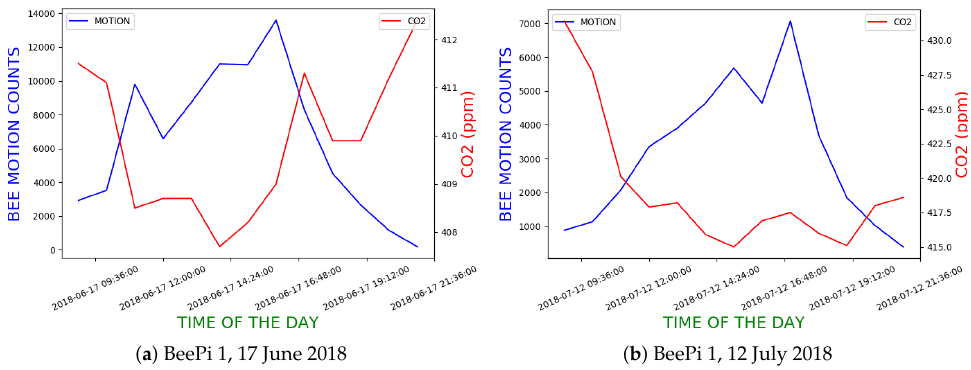
Figure 10. Alignment of CO 2 measurements from USU UCC weather station with BeePIV motion counts from videos from BeePi monitor 1 in Logan, UT.